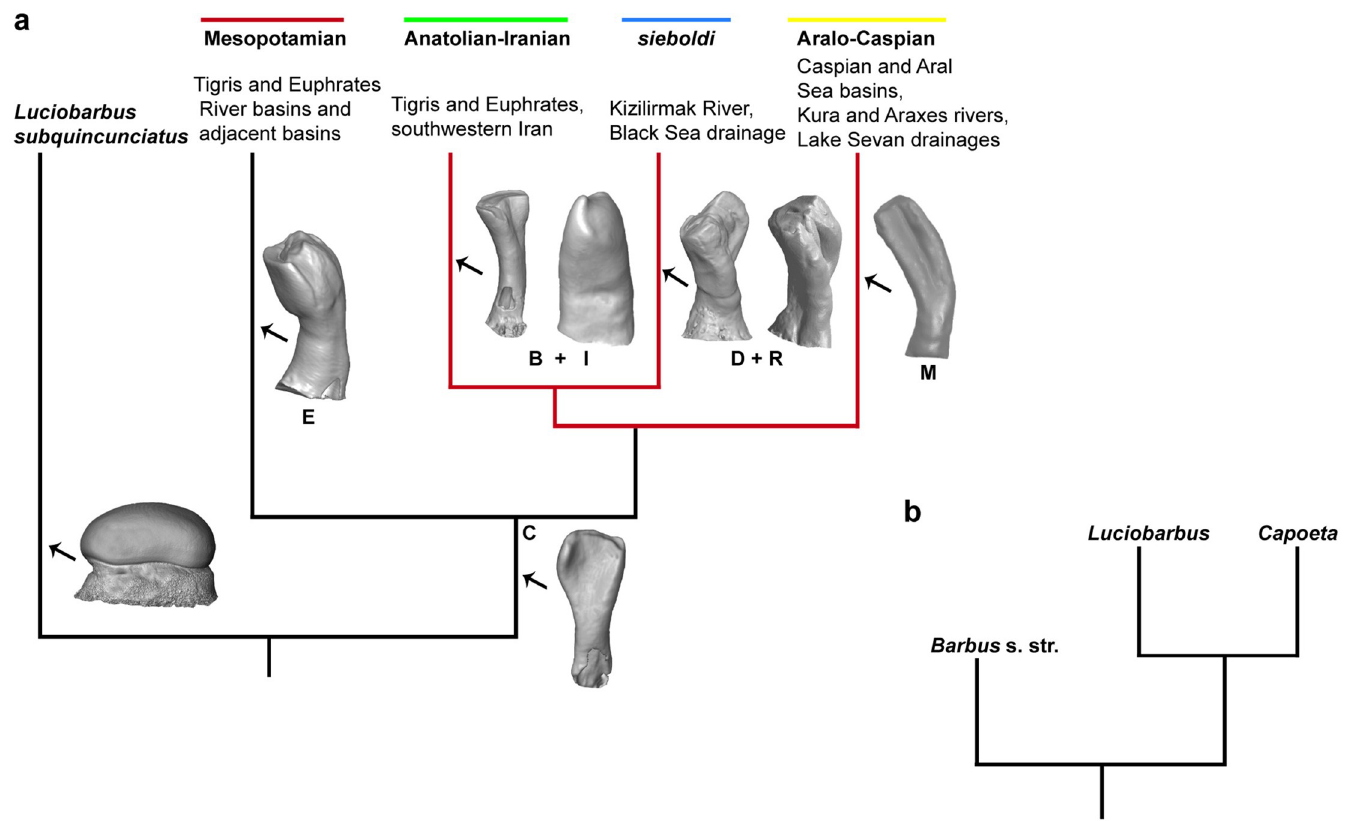
Fig 3. Phylogeny of the genus Capoeta . ( a ), distinguished clades within the genus Capoeta ( Luciobarbus suquincunciatus is the sister clade) (Levin et al., 2012). The clade diagnostic shape classes of recorded clades within the fossil material (see, Ayvazyan et al. 2018; Fig 7) are given in capital letters included 3D images of teeth of Capoeta as well as the a2 tooth of L . subquincunciatus . The monophyletic Anatolia-Iranian/Aralo-Caspian/ sieboldi clade, for which we propose a species flock model of evolution, is marked by red colour. ( b ), the location of Capoeta clade within phylogenetic tree based on the molecular genetic analysis (Levin et al.,